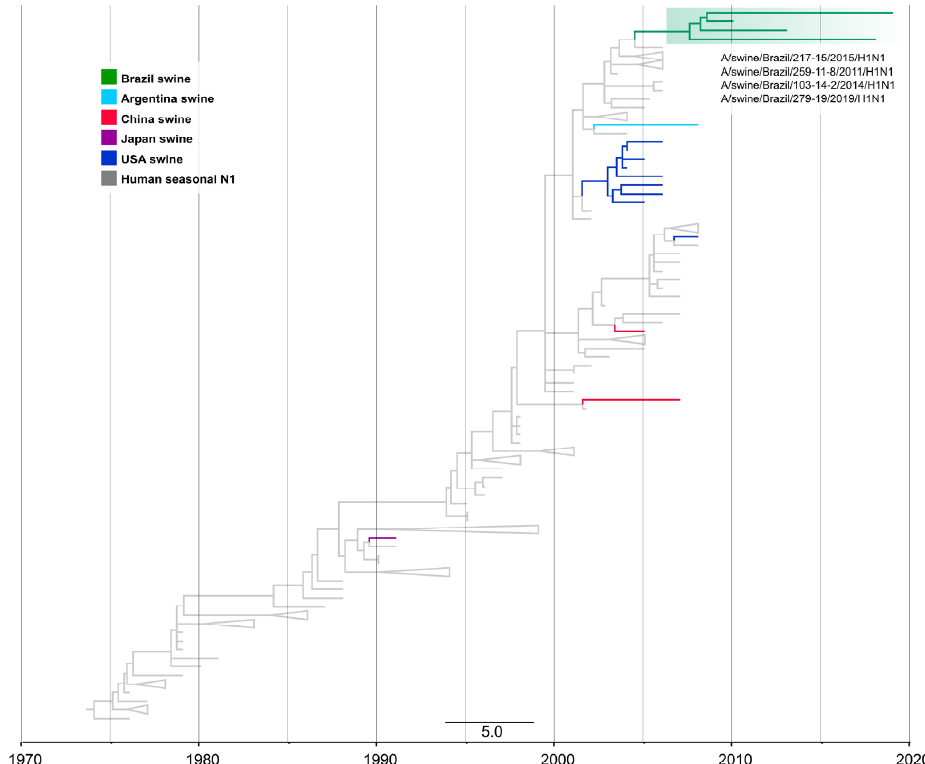
Figure 5. Time-scaled phylogeny demonstrating time of spillover of the human seasonal N1 NA segment into swine in Brazil. Phylogenetic relationships of the N1 sequences from 17 H1N1 swine influenza virus isolates collected globally during 1992–2019 and 133 human seasonal H1N1 influenza viruses collected globally from humans during 1977–2009 (total dataset, n = 150 N1 sequences). Gray branches indicate human isolates. Branches associated with viruses from swine isolates are shaded by country of origin. The Brazilian clade is highlighted in green. Branch support values (aLRT/UFboot) > 85 are provided for key nodes.